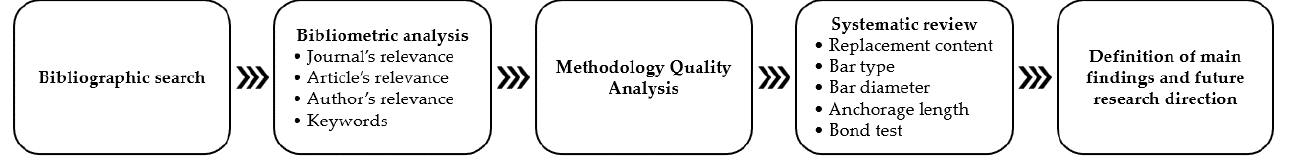
Figure 2. Main stages of this research.